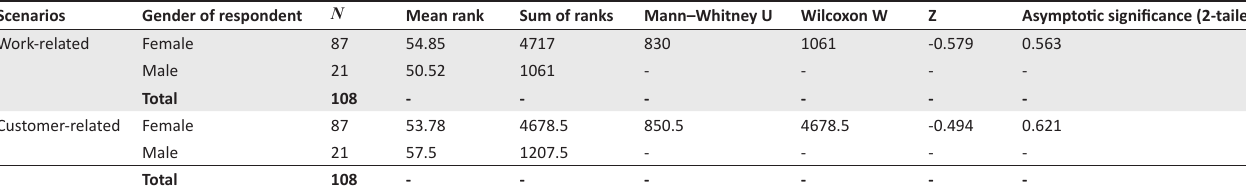
TABLE 3: Results of the Mann–Whitney U with gender as the grouping variable. Scenarios